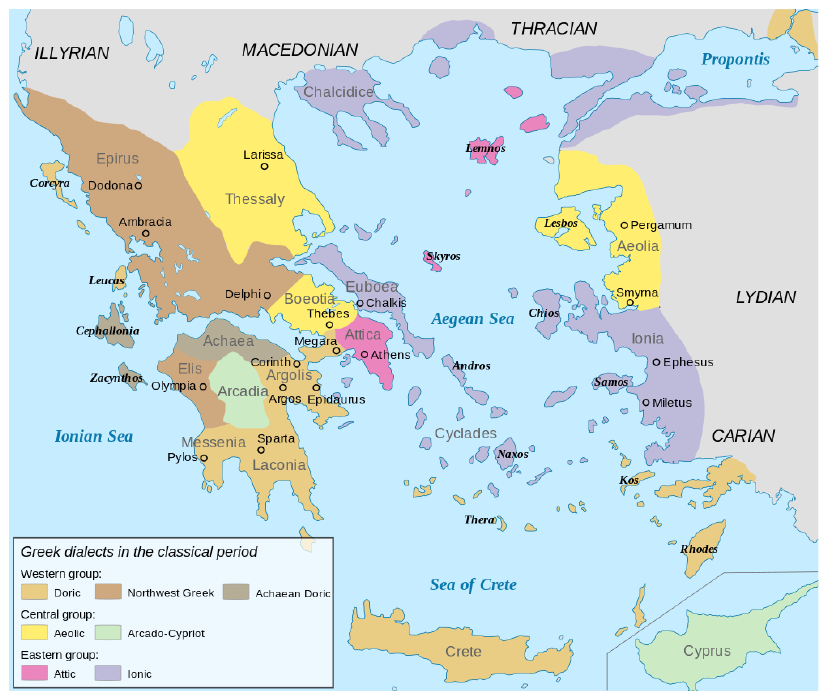
Figure 1 : Greek dialects in the classical period (ca. 500-300 BCE